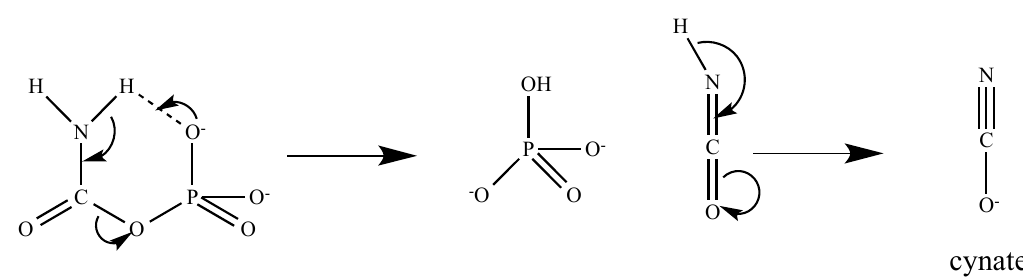
Figure 7. Schematic drawing for the proposed thermal decomposition of CP via an intramolecular proton transfer. In this conformation, the P-O-C-N dihedral angle is close to 0°.